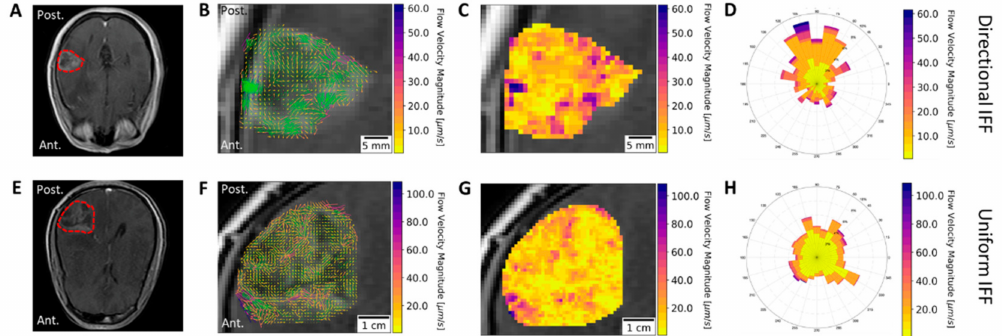
Figure 5. Directional versus non-directional IFF in glioblastoma (GBM) patients. Post gadolinium T1-weighted images of patients ( A ) W-43 and ( E ) W-48, with tumors outlined. Results from IFF analysis consist of ( B , F ) images including streamlines (green) and vectors (color bar) for velocity, ( C , G ) heat maps, and ( D , H ) rose plots. The results from patients W43 and W48 are plotted as examples of directional and uniform IFF,